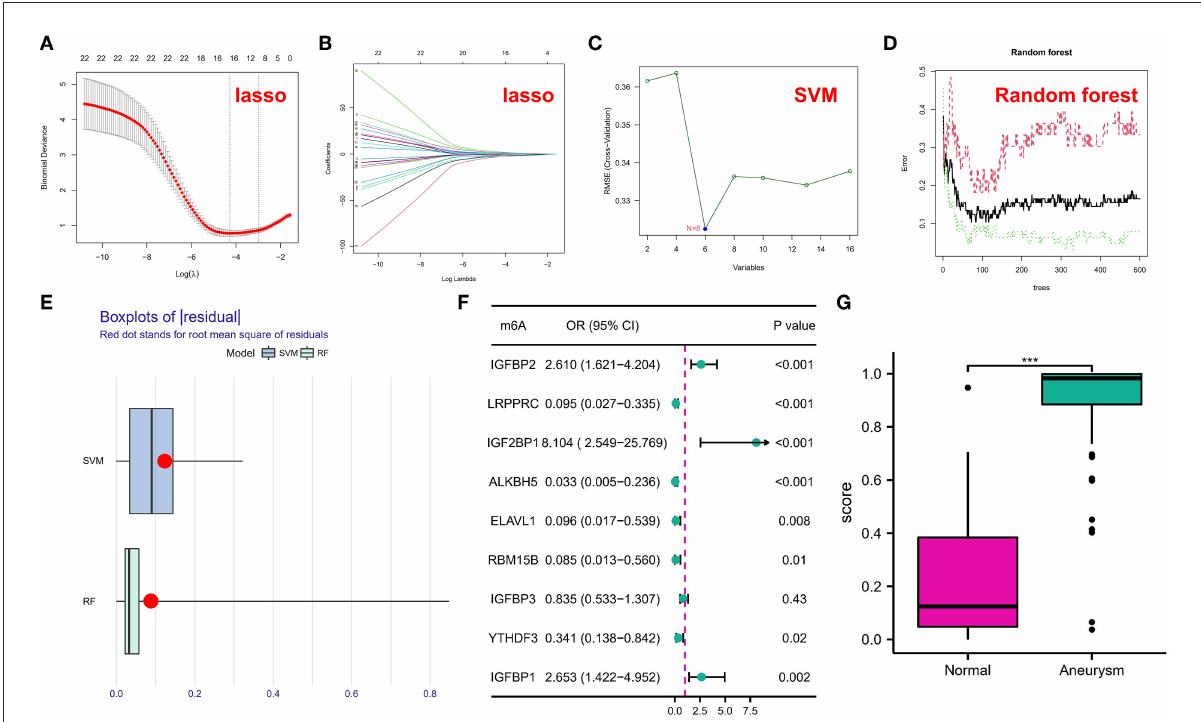
FIGURE2 (A,B) Coefficient profiles of intracranial aneurysm (IA)-associated m6A modulators using the least absolute shrinkage and selection operator (Lasso). Cross-validation by 10-fold regression is used to fine-tune the parameter selection of Lasso. (C) Support vector machine (SVM) models. (D) Error graph of the random forest (RF) models. (E) Box plots of residuals in SVM and RF. (F) Correlation between m6A regulators and IA was explored utilizing univariate logistic regression, identifying nine m6A modulators associated with IA ( P < 0.05). (G) Risk distribution for IAs and normal samples, with IAs having a significantly elevated risk score as opposed to normal samples. The symbol *** indicates he value of p < 0.001.